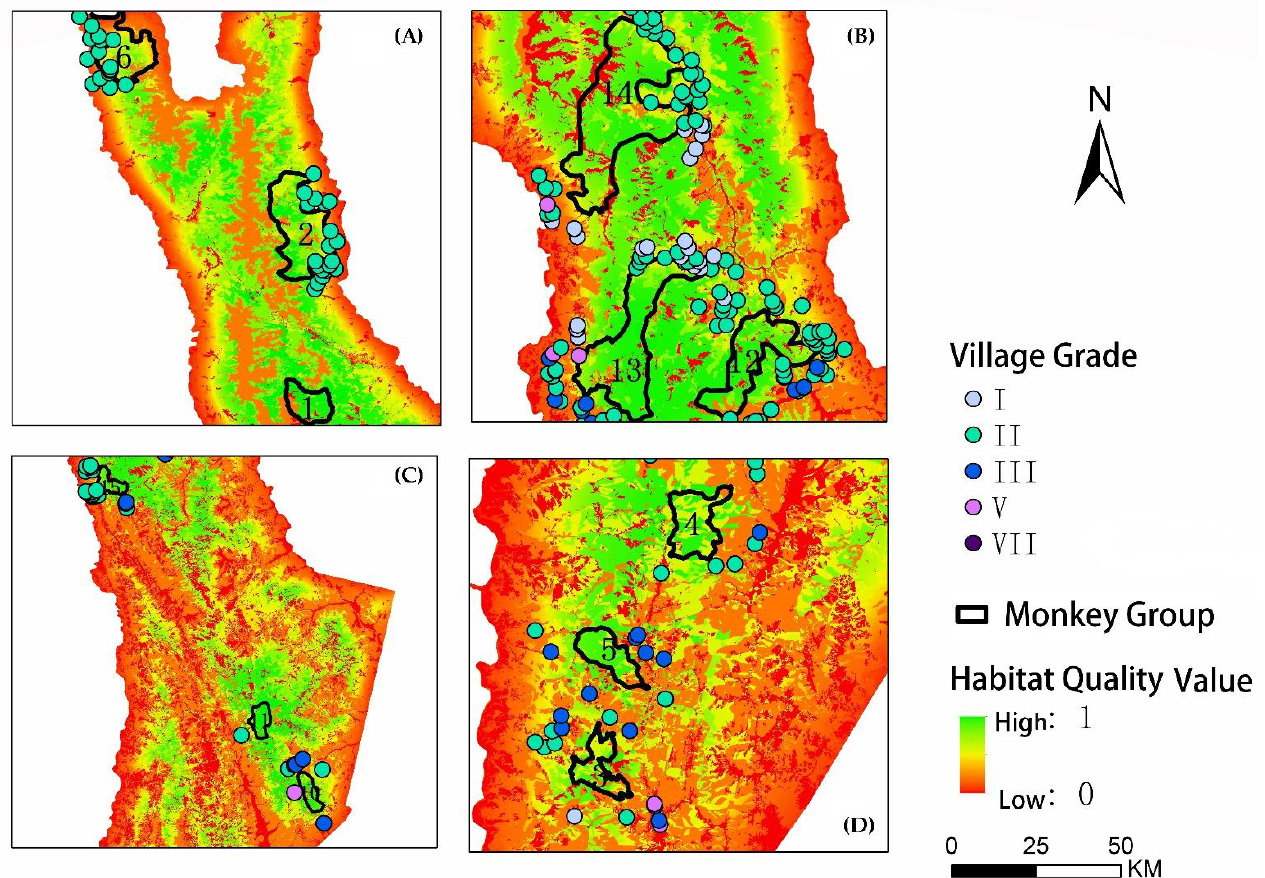
Figure 6. Zoom-in of four sections of the research area, showing the distribution of villages and habitat quality in relation to each monkey group. ( A ) Northern part of the area showing groups C1, C2, and C6. ( B ) North-central part of the area showing groups C12, C13, and C14. ( C ) South-central part of the area showing groups C10, C11, and C15. ( D ) Southern part of the area showing groups C3, C4, and C5.